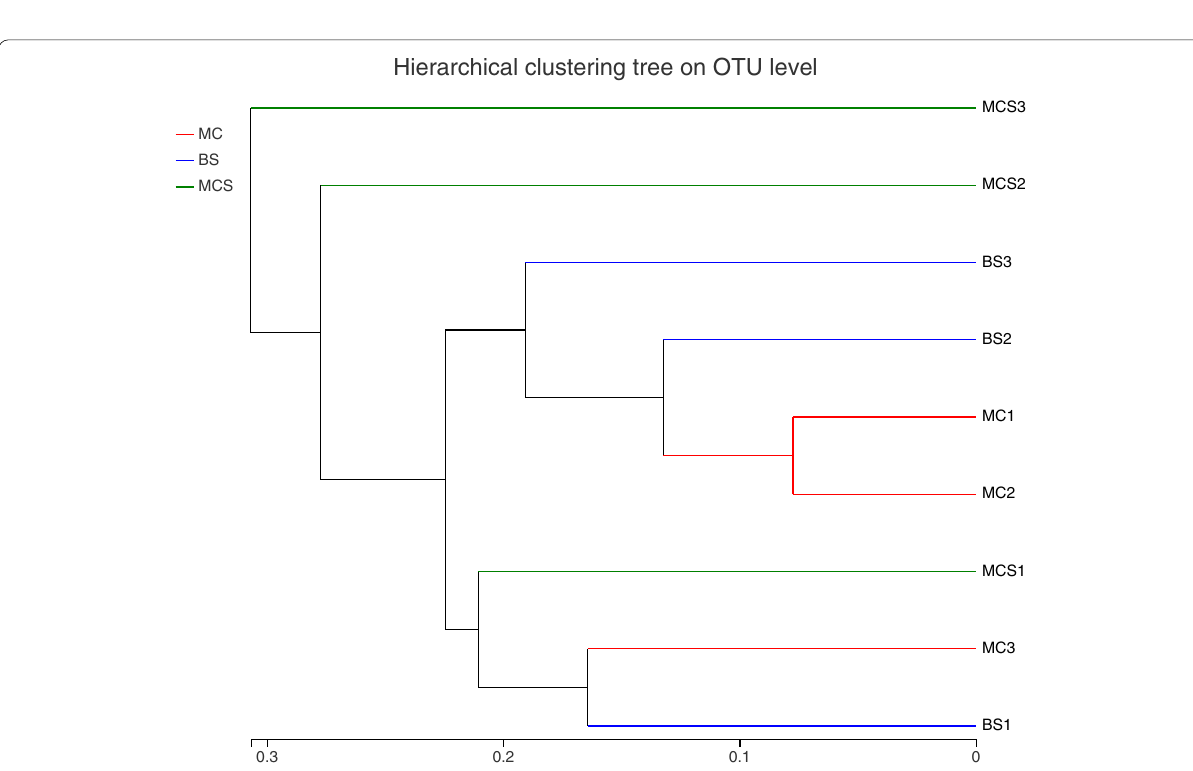
Fig. 5 Plots of hierarchical clustering based on OUT’s level. Notes: MC, BS, and MCS are the same as in Fig.